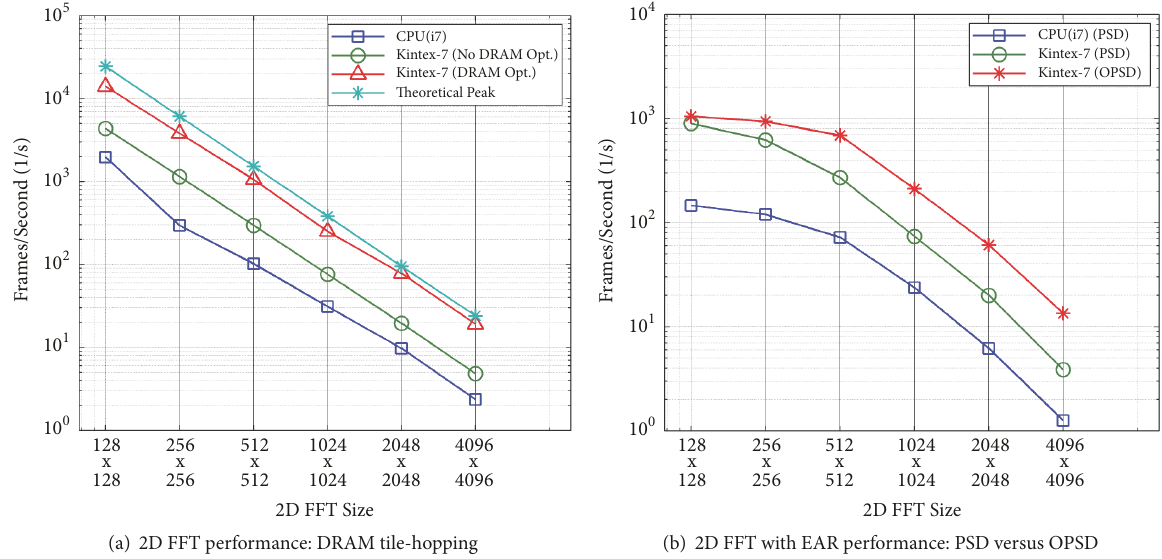
Figure 10: Performance evaluation in terms of frames per second for (a) 2D FFTs with tile-hopping memory pattern. (b) 2D FFTs with edge artifact removal (EAR) using OPSD. The performance evaluation shows the significance of the two optimizations proposed. Both axes are on a log